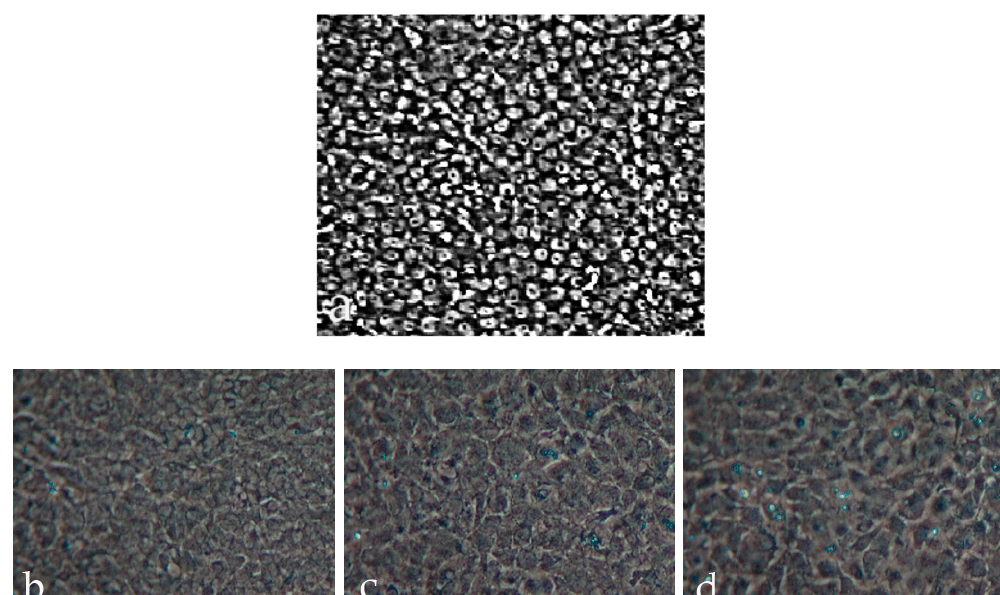
Figure 7. M2H4 cell morphology with different culture medium: (1) no recombinant protein; (2) ascorbic acid; (3) recombinant DSP 307 protein; and (4) recombinant DSP 430 /PP 240 protein mixture. ( a ) M2H4 cells cultured with conditioned medium (containing anti-sense DSP-PP cDNA; no recombinant protein) without ascorbic acid, showed highly packed rounded cells;( b ) M2H4 cells with conditioned medium and ascorbic acid showed cells were spread out;( c ) M2H4 cells with recombinant DSP 307 protein showed more spread out cell structure; and ( d ) M2H4 cells with recombinant DSP/PP 240 protein mixture showed more spread out cells. For details about each group treatment, please see Section 2.2.4.